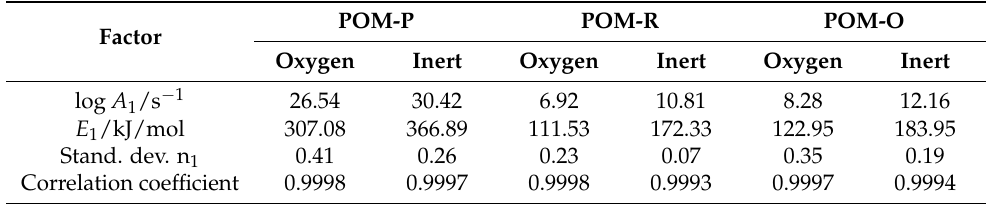
Table 6. Kinetic parameters determined by non-linear regression for thermal and thermo-oxidative degradation of POM-P, POM-R, and POM-O.